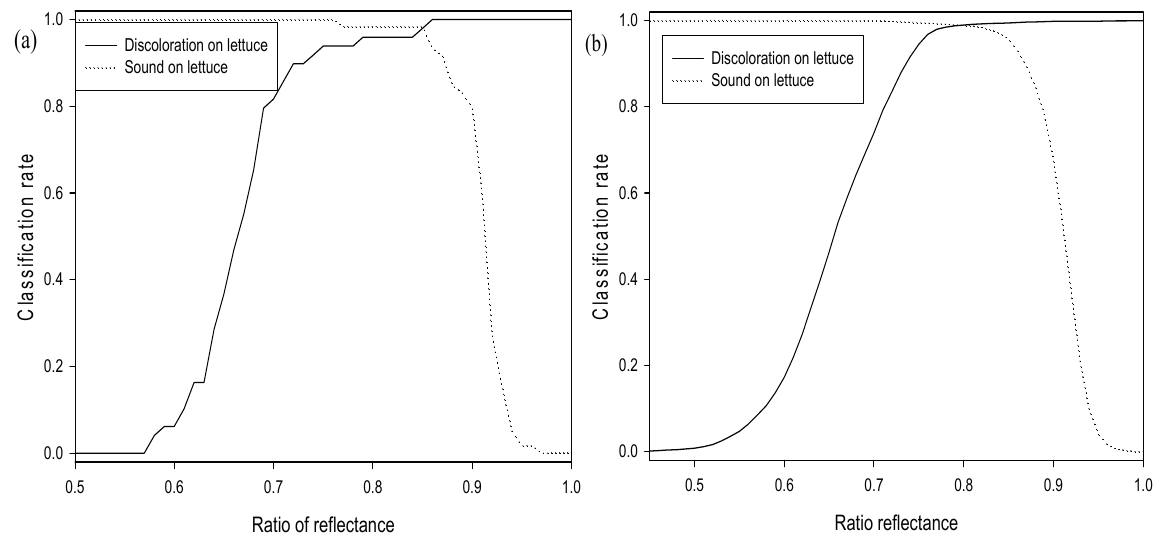
Figure 7. Waveband selection for the ratio spectra and imaging algorithm. One-way ANOVA results for classifying sound and discolored areas of the lettuce surface using the ratio of two wavebands in the wavelength range from 400 to 1000 nm.